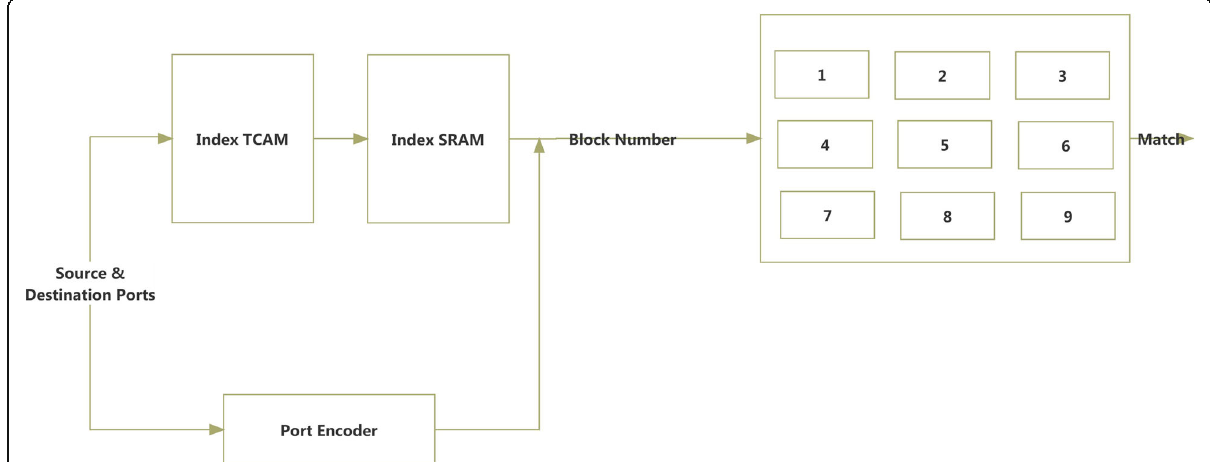
Fig. 4 Architecture of the proposed